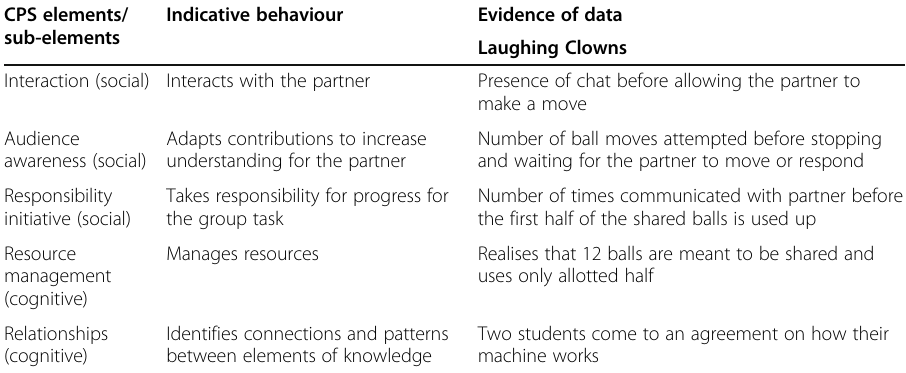
Table 1 Social and cognitive CPS elements/sub-elements and indicative behaviours in the Laughing Clowns